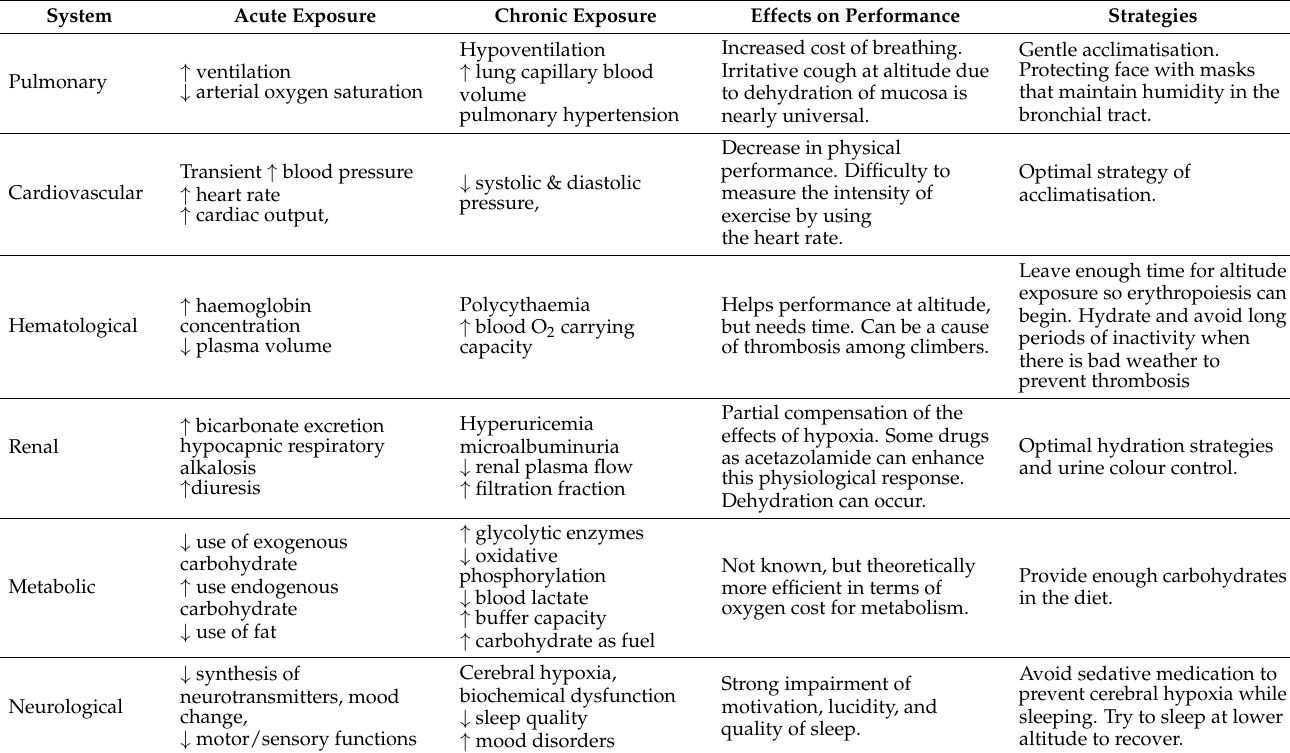
Table 3. The pathophysiological effects of acute and chronic